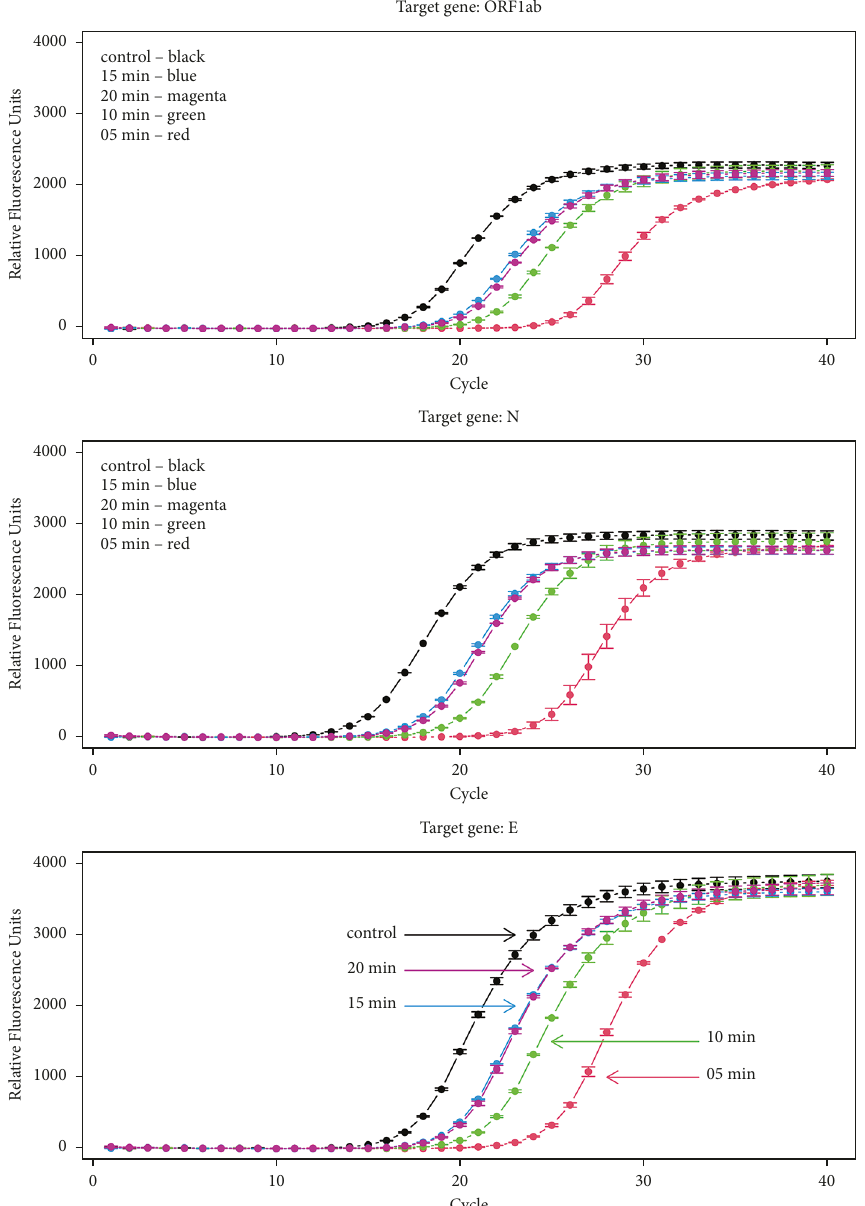
Figure 1: Amplification curves of a pool of RNA from COVID-19-positive patients in the presence of saliva pretreated at 95 ° C for 5 (red), 10 (green), 15 (blue), and 20 minutes (magenta). The control curve is shown in black. Curves correspond to a 1:10 dilution of the RNA